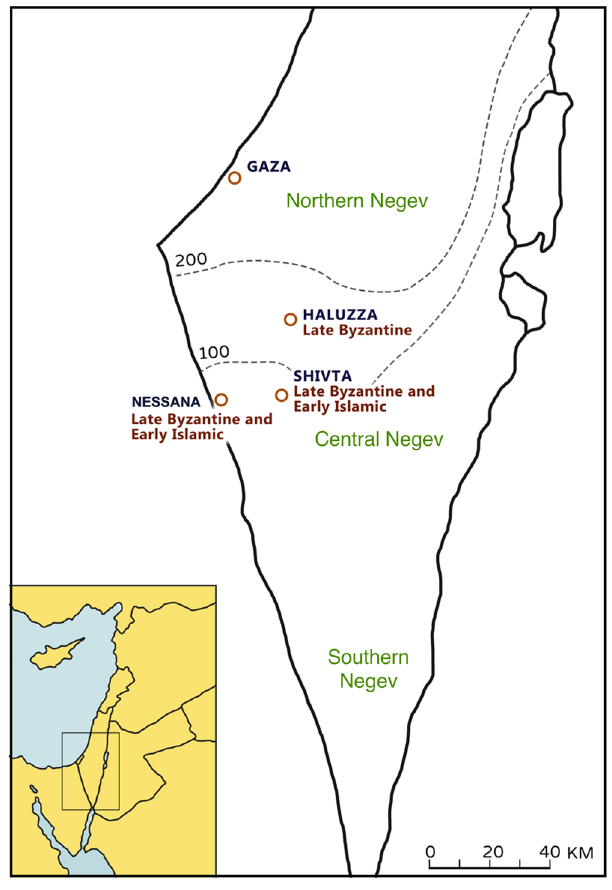
Figure 1. Location of study sites in the Negev Desert, southern Levant. Elusa (Halutza), Nessana (Nitzana) and Subeita (Shivta). Adapted from Marom et al . 13